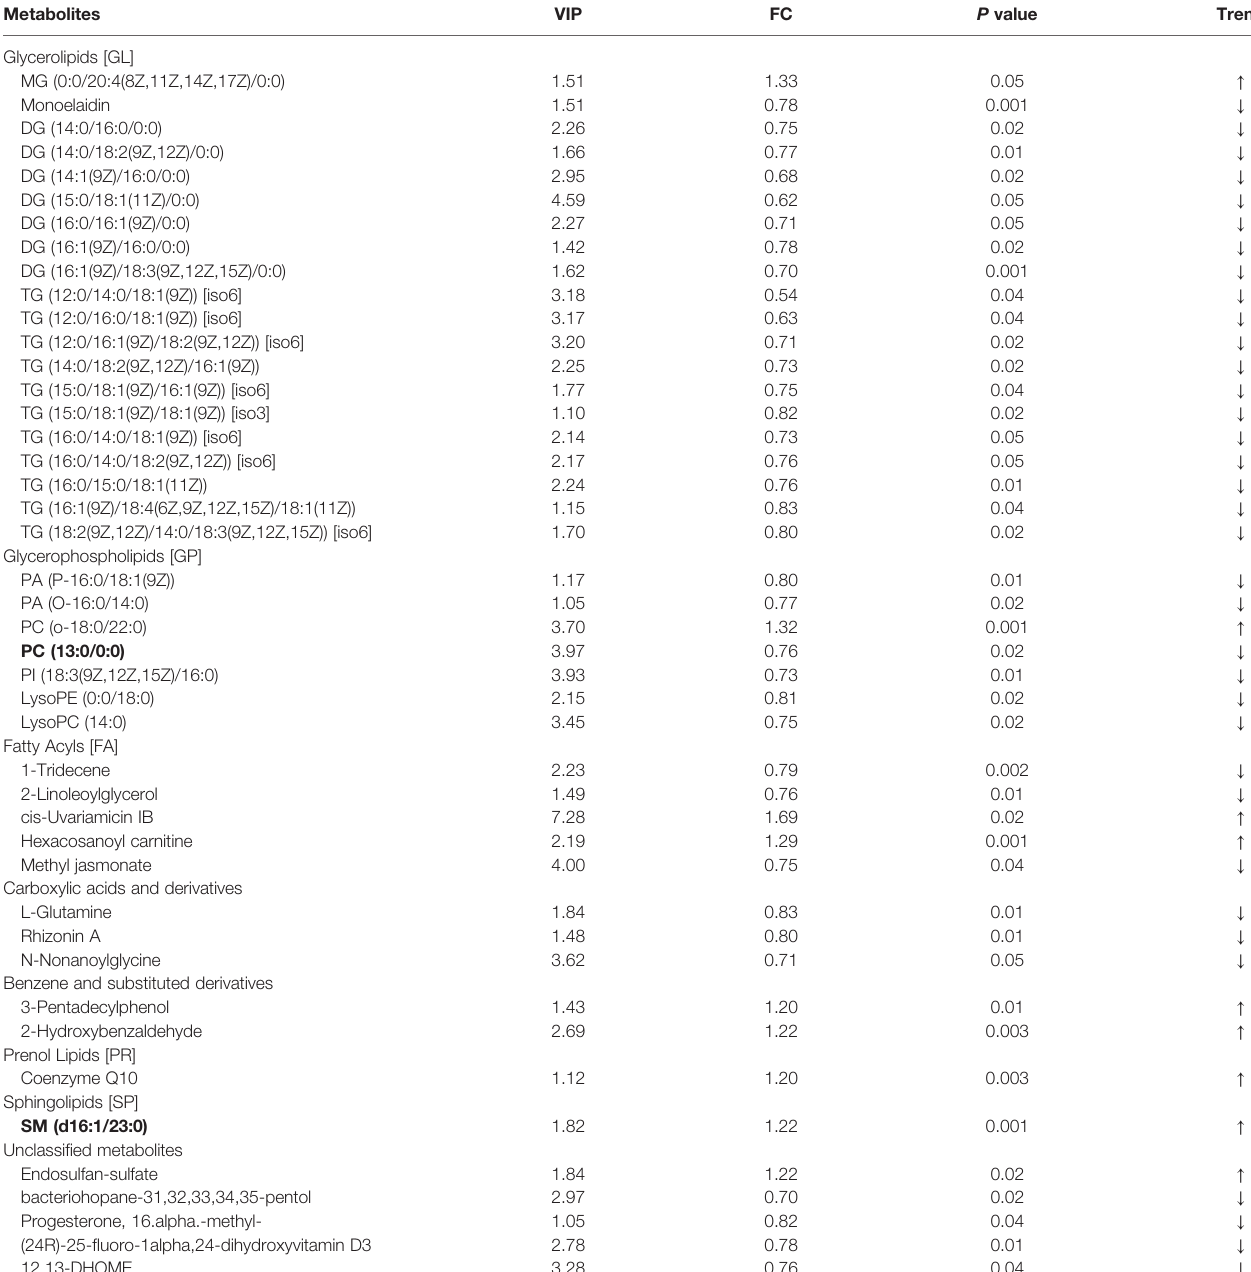
TABLE 3 | Metabolites altered between study groups in the general offspring. Metabolites VIP FC P value Trend Glycerolipids [GL] MG (0:0/20:4(8Z,11Z,14Z,17Z)/0:0) 1.51